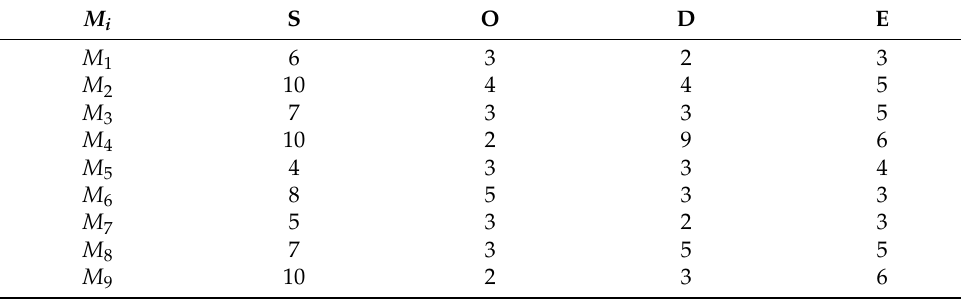
Table A1. The initial questionnaire obtained by Expert